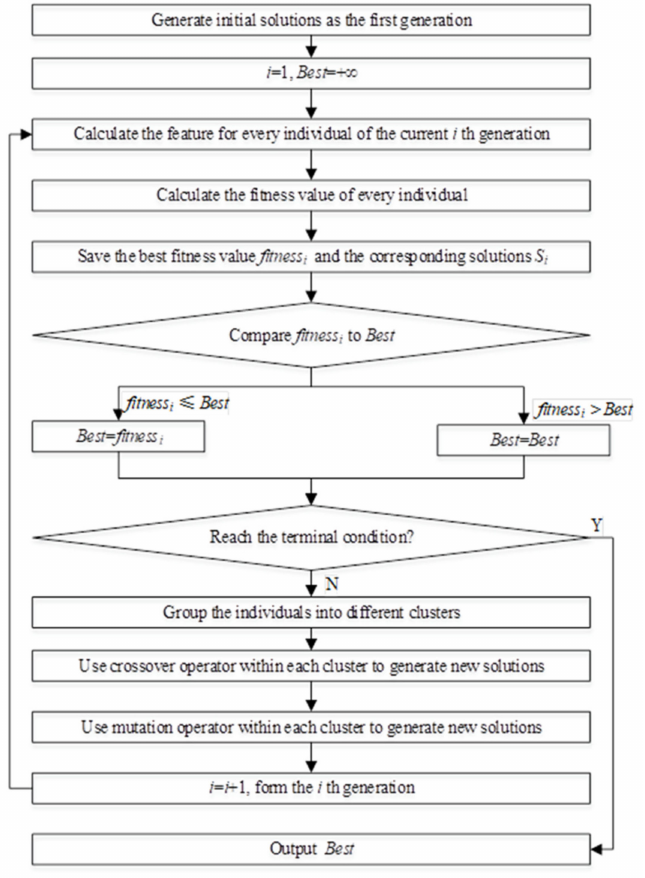
Figure 4. Flow chart of the proposed